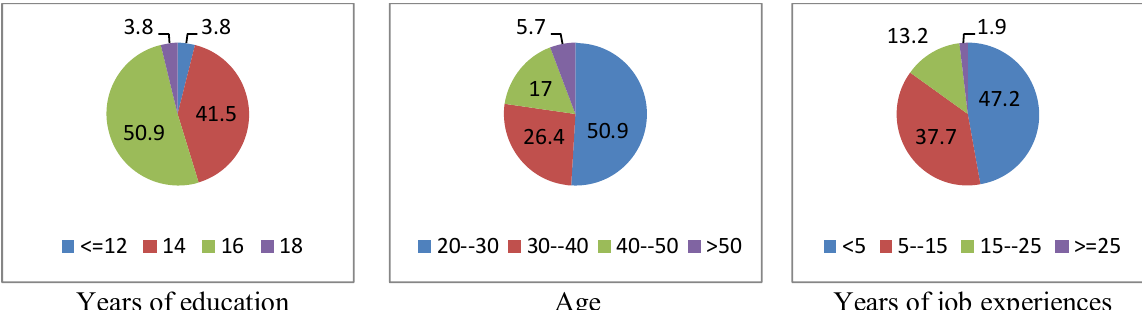
Fig. 2. Personal characteristics of the